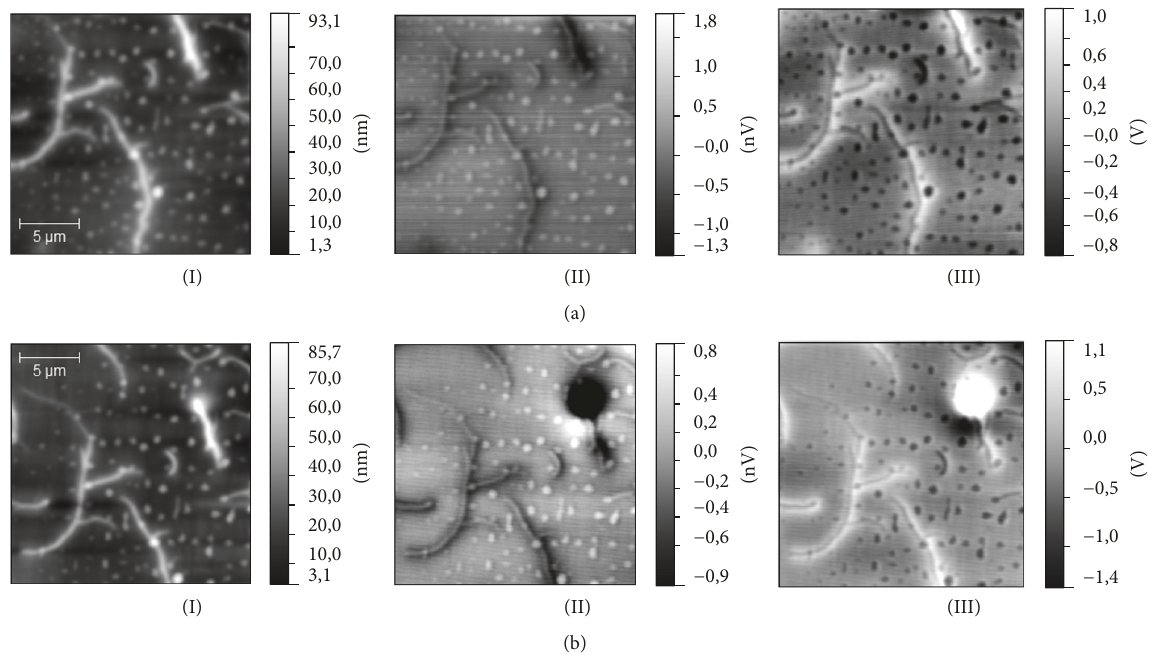
Figure 9: The results of MFM measurements in magnetic field: (I) topography of the sample, (II) MFM amplitude, and (III) MFM phase. (a) S4 sample in the absence of magnetic field; (b) S4 sample in the presence of magnetic field. 0.6 T was applied coaxial to 𝑌 direction and parallel to the